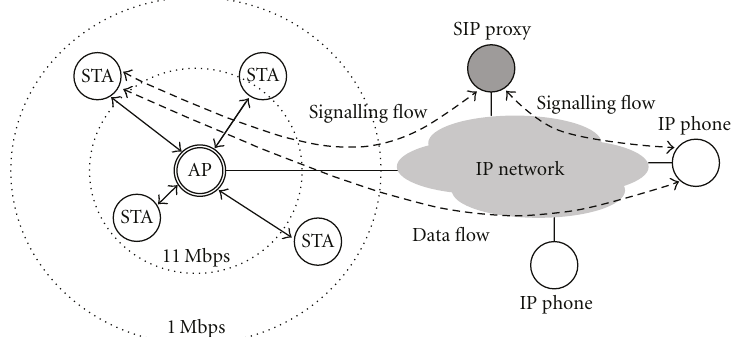
Figure 2: A VoIP WLAN Hotspot scenario.